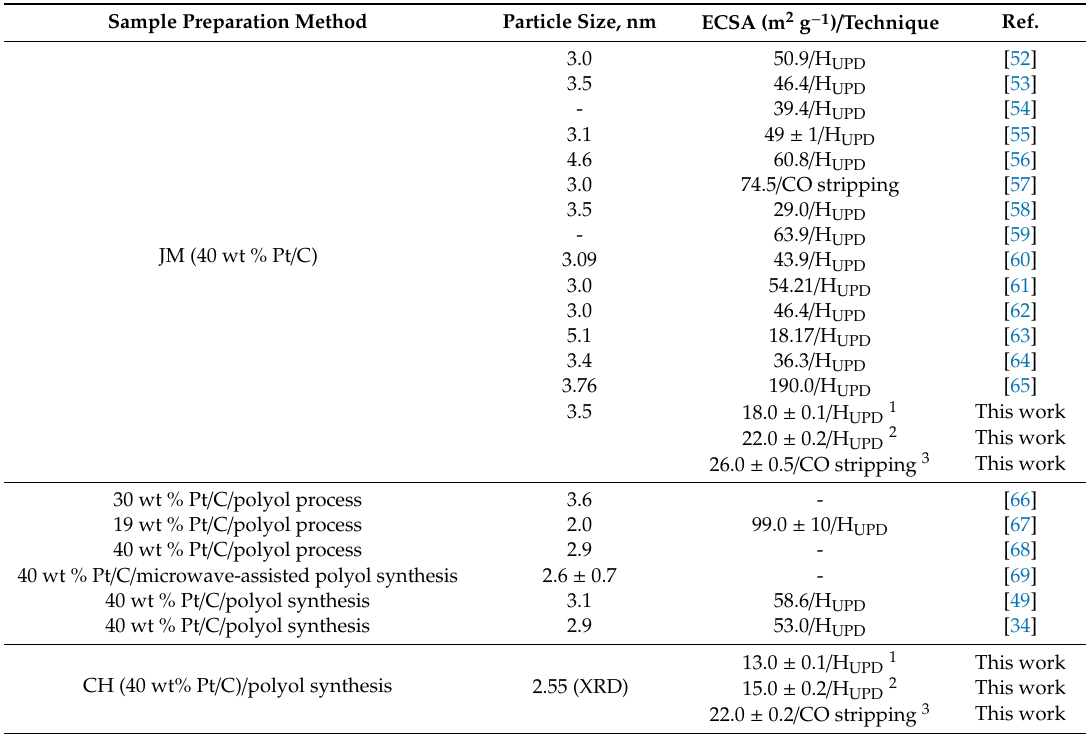
Table 3. Comparative ECSA values of Pt / C electrocatalysts obtained by polyol methods and the commercial JM catalyst in di ff erent